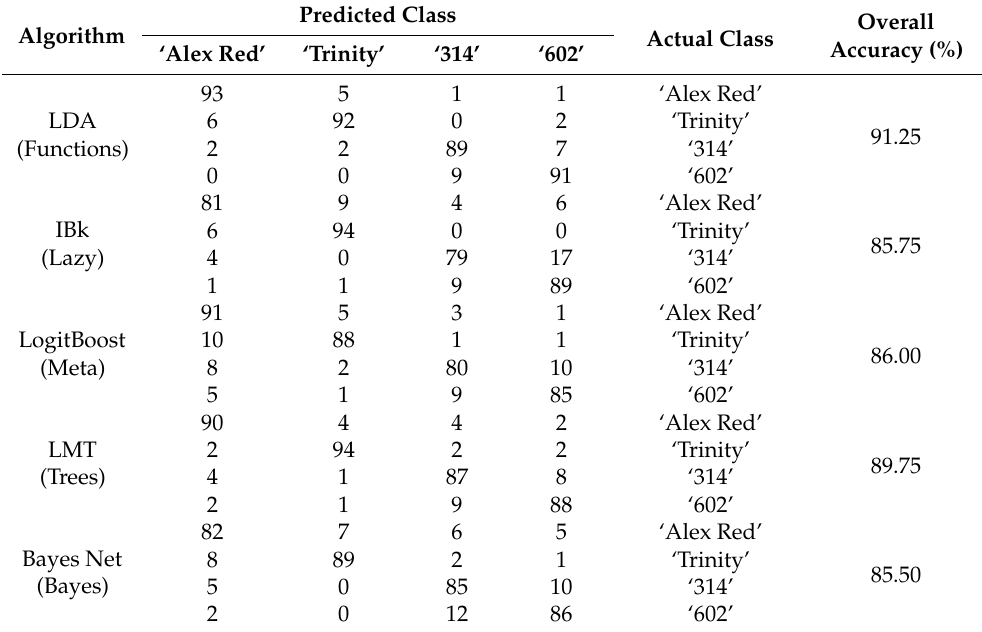
Table 4. The number of correctly and incorrectly classified cases and overall accuracies of distinguish- ing freeze-dried red-fleshed apple slices based on features selected from a set of image textures and color